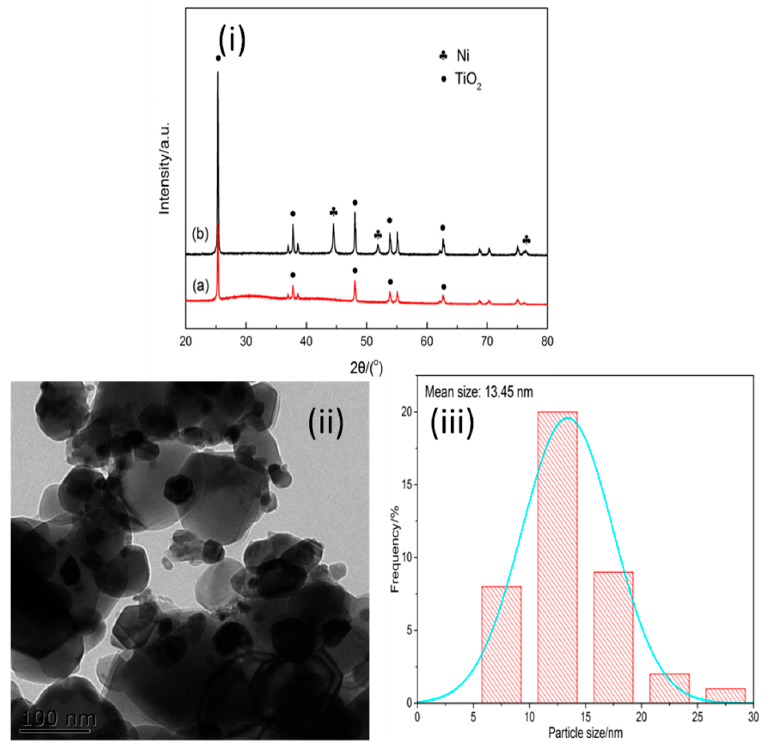
Figure 2. ( i ) XRD patterns of TiO 2 (a) and 20 wt.% Ni/TiO 2 (b), ( ii ) TEM image of 20 wt.% Ni/TiO 2 , ( iii ) Particle size of Ni on the TiO 2 particles.